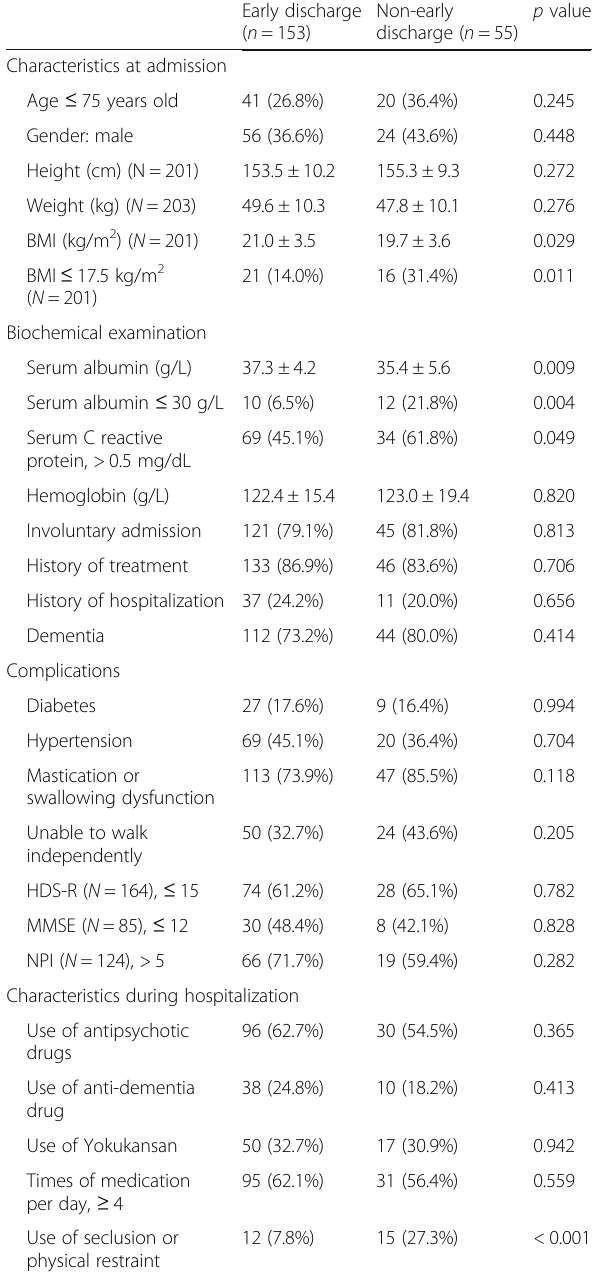
Table 2 Comparison of each factor between the early discharge group and the non-early discharge group